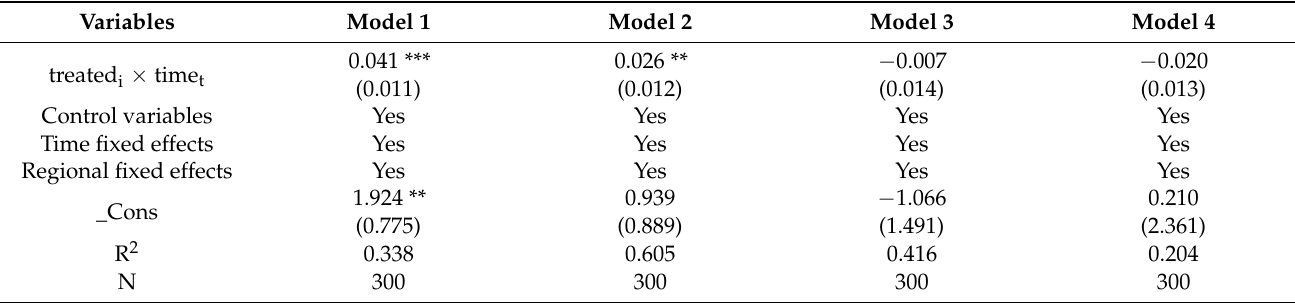
Table 6. Unconditional quantile regression